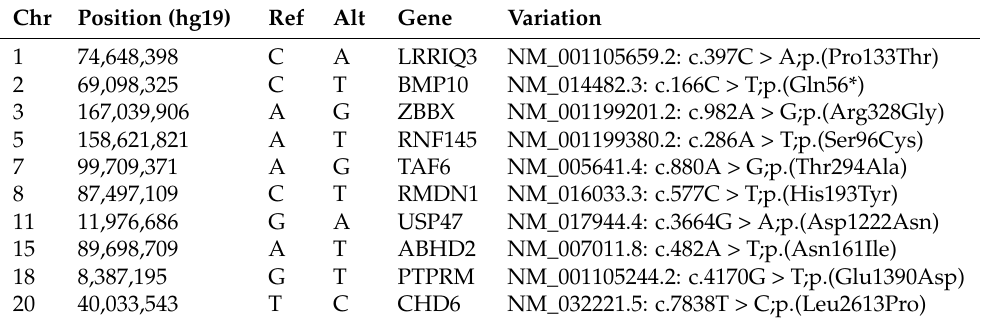
Table 2. Nonsynonymous candidate gene variations for dilated cardiomyopathy discovered by whole-exome sequencing